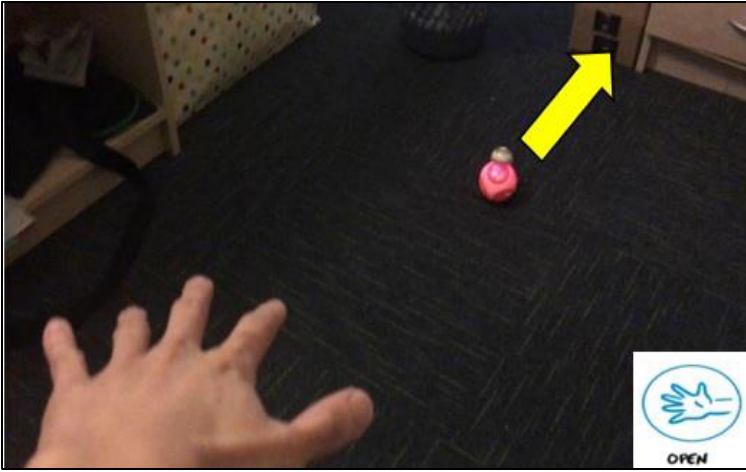
Figure 5. Finger Spread gesture activates Forward robot motion